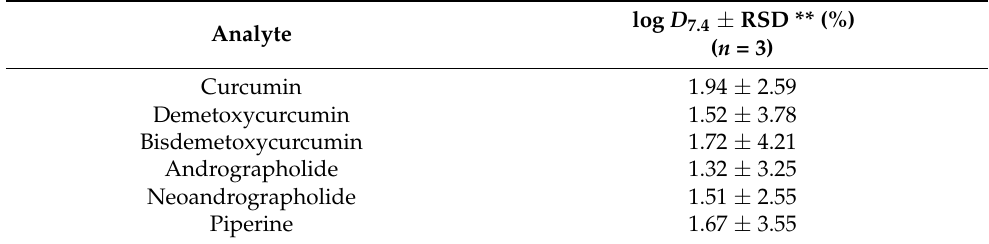
Table 3. Log D 7.4 values * of biologically active ingredients of botanicals used in IBD treatment determined by applied shake-flask